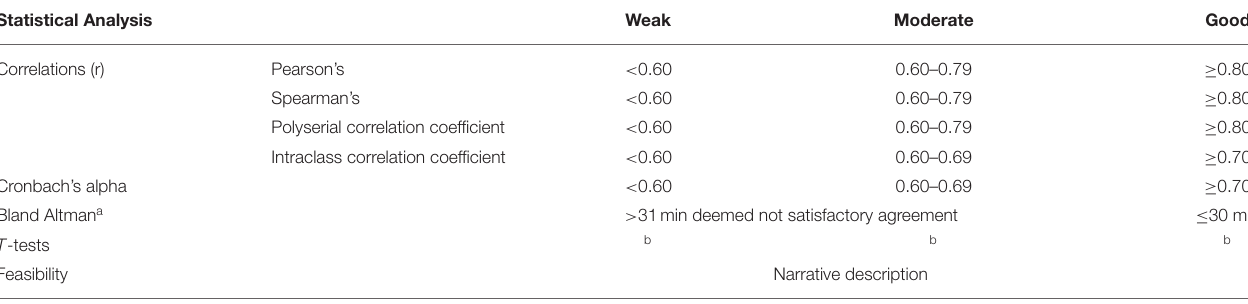
TABLE 2 | Main statistical analyses and interpretation of statistics. Statistical